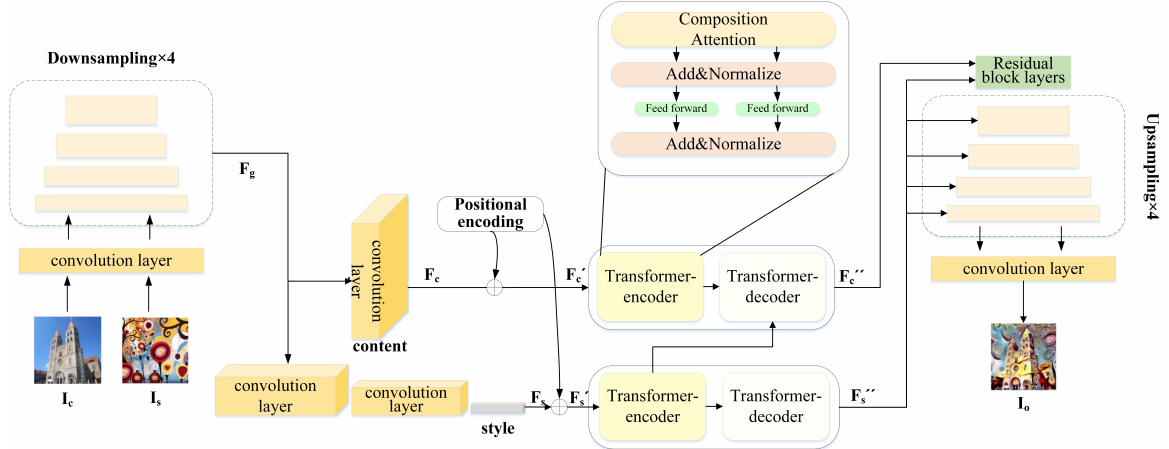
Figure 1. The network architecture of our proposed compositional transformer model which is composed of an encoder combining CNN and compositional attention blocks, and a StyleGAN2- based